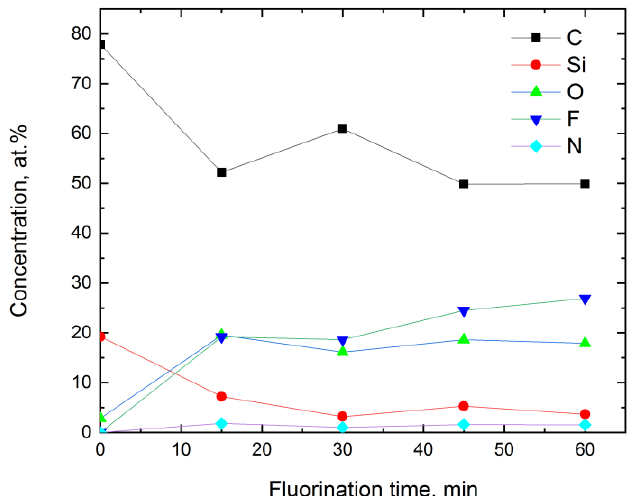
Figure 6. Change in the concentration of elements on the surface of PVTMS samples determined by XPS depending on the fluorination time.